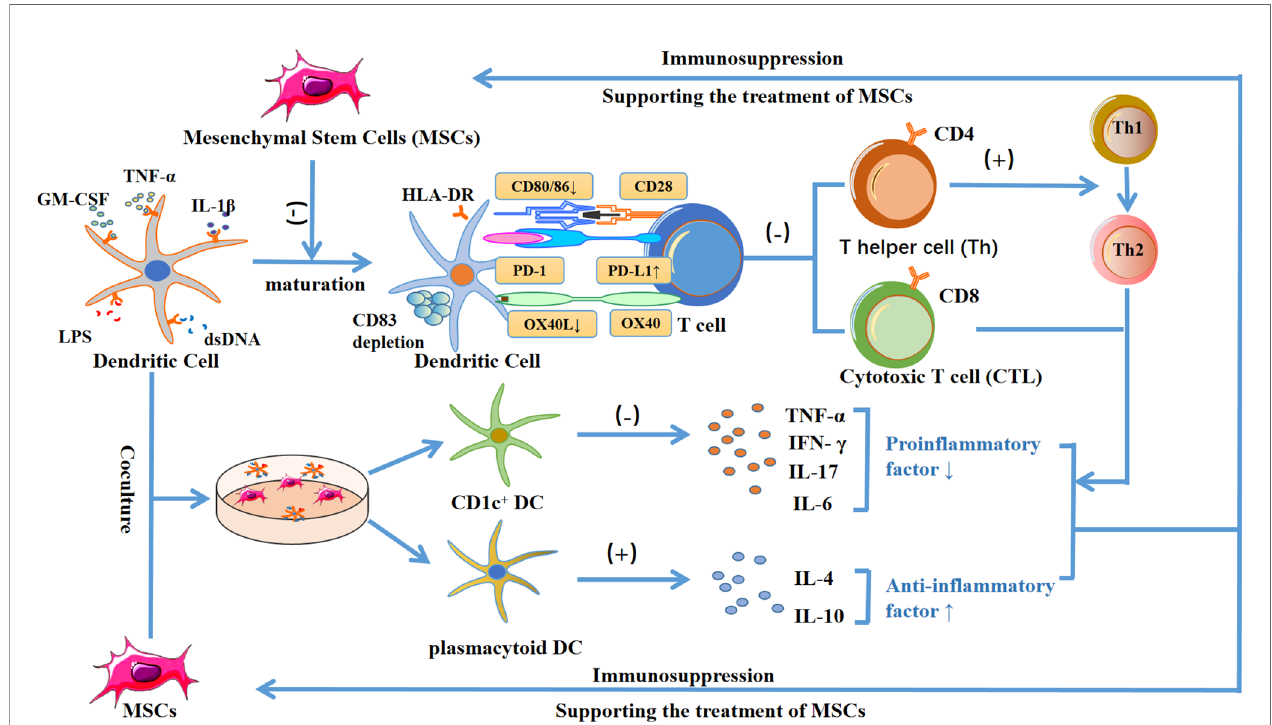
FIGURE 4 | Diagram showing the mechanism by which MSCs inhibit the maturation of dendritic cells, reduce the ability to activate T cells, and decrease HLA-DR, CD40, OX40L, CD80, CD83, CD86 expression, while increasing PD-L1 expression. This process causes the inhibition of CD4 + and CD8 + T cells by paracrine or cell contact. On the one hand, inhibiting CD4 + helper T cells can inhibit the binding of CD40 ligands with CD40 on the surface of dendritic cells, thereby reducing the transformation to CD8 + T cells. In addition, inhibiting CD4 + helper T cells can reduce the release of IL-2 and formation of CD8 + T cells, and ultimately reduce the release of pro-in fl ammatory cytokines TNF- a and IFN- g . On the other hand, MSCs can induce the differentiation of regulatory T cells and trigger dendritic cells to promote the transformation of Th1 to Th2, resulting in a decrease of the pro-in fl ammatory cytokines TNF- a , IFN- g , IL-17 and IL-6, and an increase in the levels of the anti-in fl ammatory cytokines IL-4 and IL-10, which contributes to the treatment of MSCs. In addition, when dendritic cells were co-cultured with MSCs, the secretion of pro-in fl ammatory cytokines by CD1c + DC decreased, and the secretion of anti-in fl ammatory cytokine IL-10 by plasmacytoid DC increased, which further led to immunosuppression and supported the treatment of